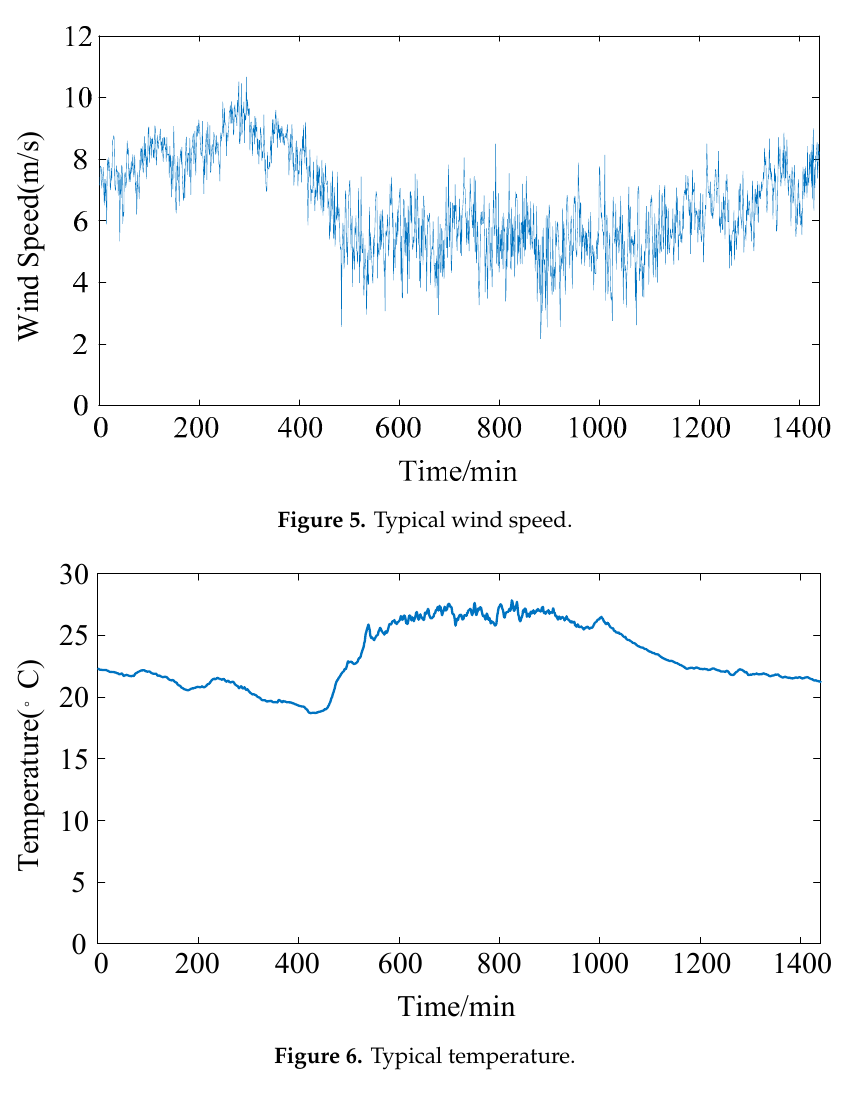
Figure 6. Typical temperature.